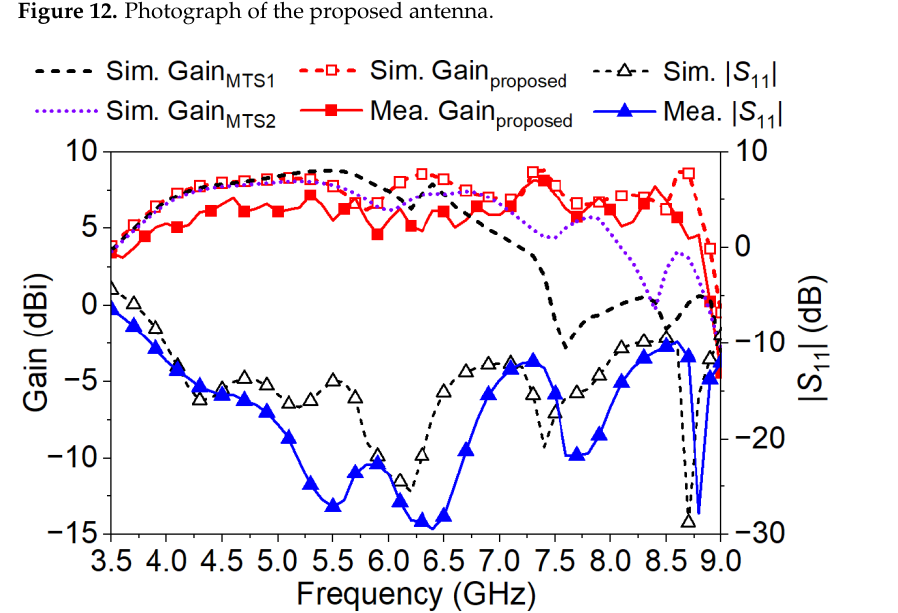
Figure 13. Measured and simulated boresight gains, | S 11 | of the proposed antenna. Simulated boresight gains of antennas with MTS1 and MTS2 are also shown.